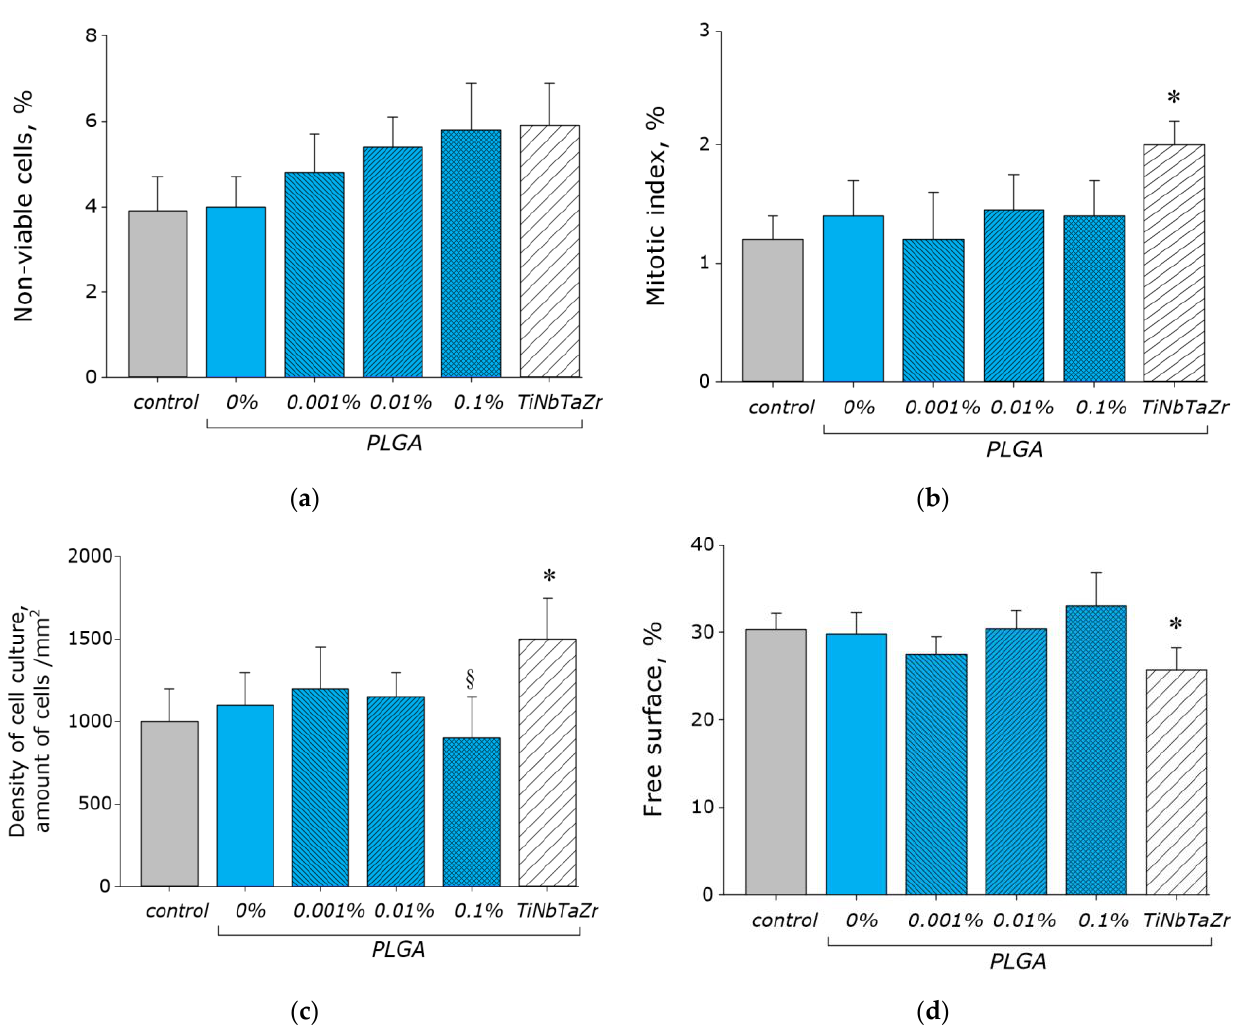
Figure 11. Effect of nanocomposite based on PLGA and Al 2 O 3 NPs on the main characteristics of growth and development of mammalian cell culture: ( a ) Influence of nanocomposite on the viability of cell culture; ( b ) Influence of nanocomposite on the mitotic index; ( c ) Influence of nanocomposite on the cell culture density; ( d ) Influence of nanocomposite on the colonization rate of free surface by cells. *—indicates a significant difference in comparison with the control ( p < 0.05). §—indicates a significant difference in comparison with the TiNbTaZr group ( p < 0.05). Data are presented as mean values and standard errors of